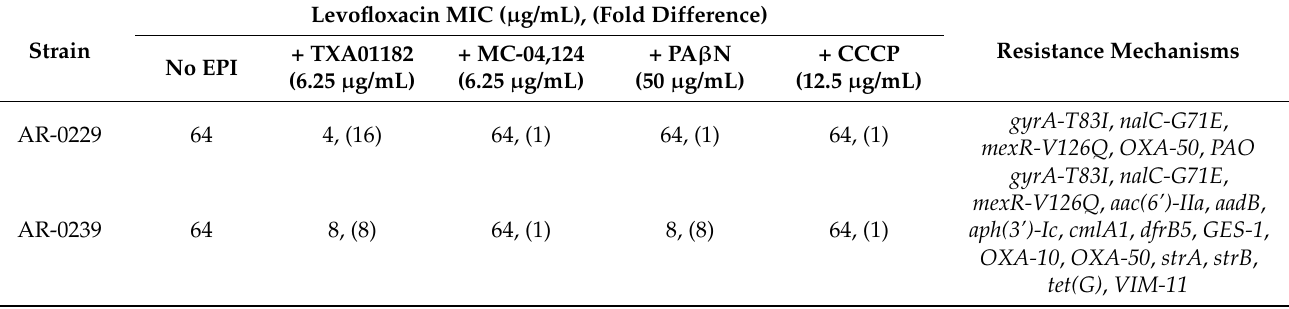
Table 4. Levofloxacin potentiation comparison between TXA01182, MC-04,124, PAβN and CCCP on multidrug resistant clinical isolates of P. aeruginosa .